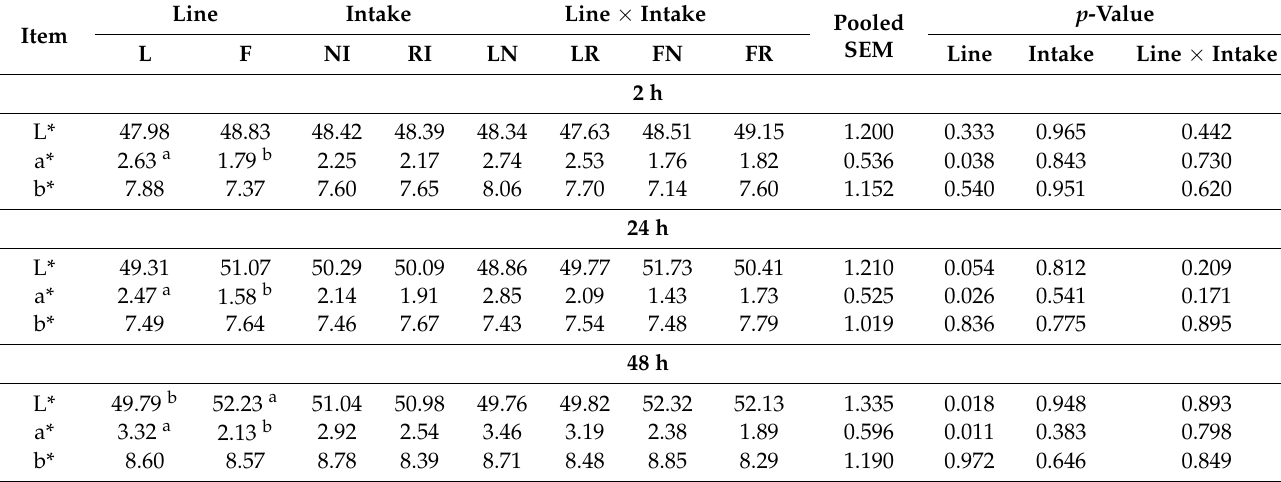
Table 2. Effect of feed intake on breast muscle color of 56-day-old offspring in broiler hens during laying period (n = 24).